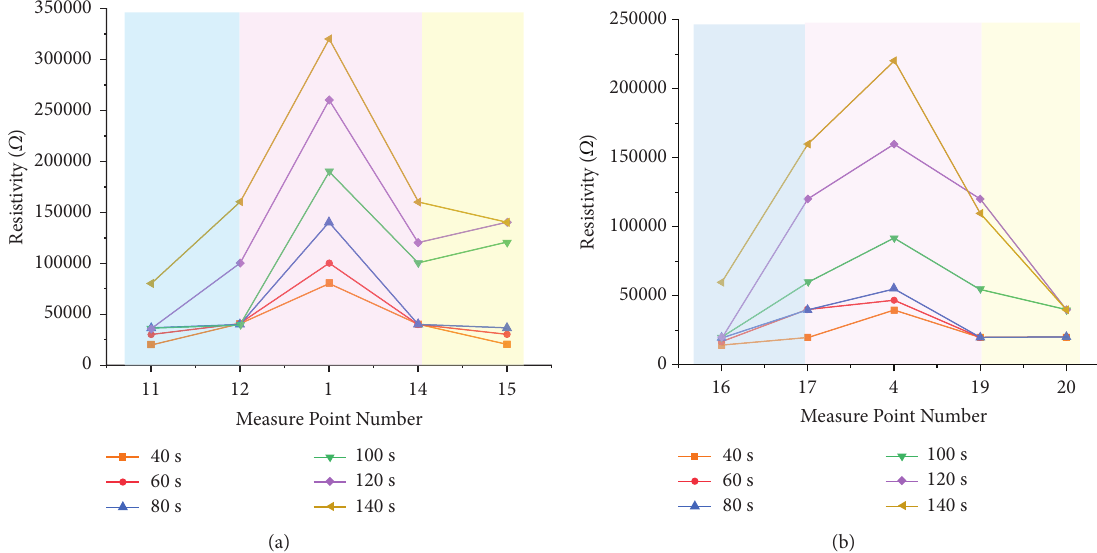
Figure 13: Electrical resistivity distributions along the lateral direction. (a) At the top section of the rock specimen. (b) In the middle of the rock Table 3: P-wave velocities after ultrasonic vibration for various periods of time. Monitoring location